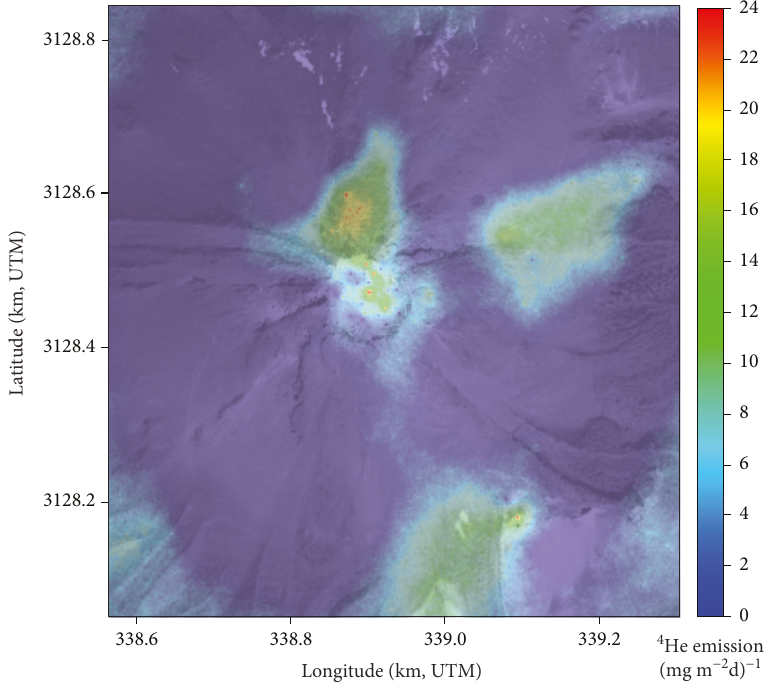
Figure 4: A plot of 13 δ C(CO geochemical reservoirs: air, characterized by a δ 13 C CO O = 100 % , and biogenic CO 2 is represented by straight lines. CO 2